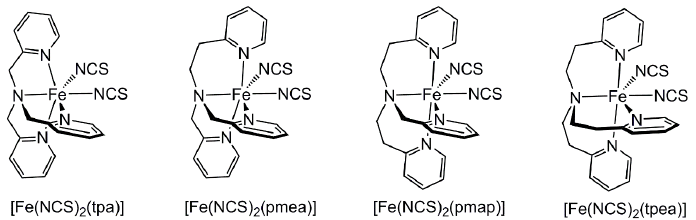
Scheme 5. A series of complexes with sequentially expanded chelate ring sizes.